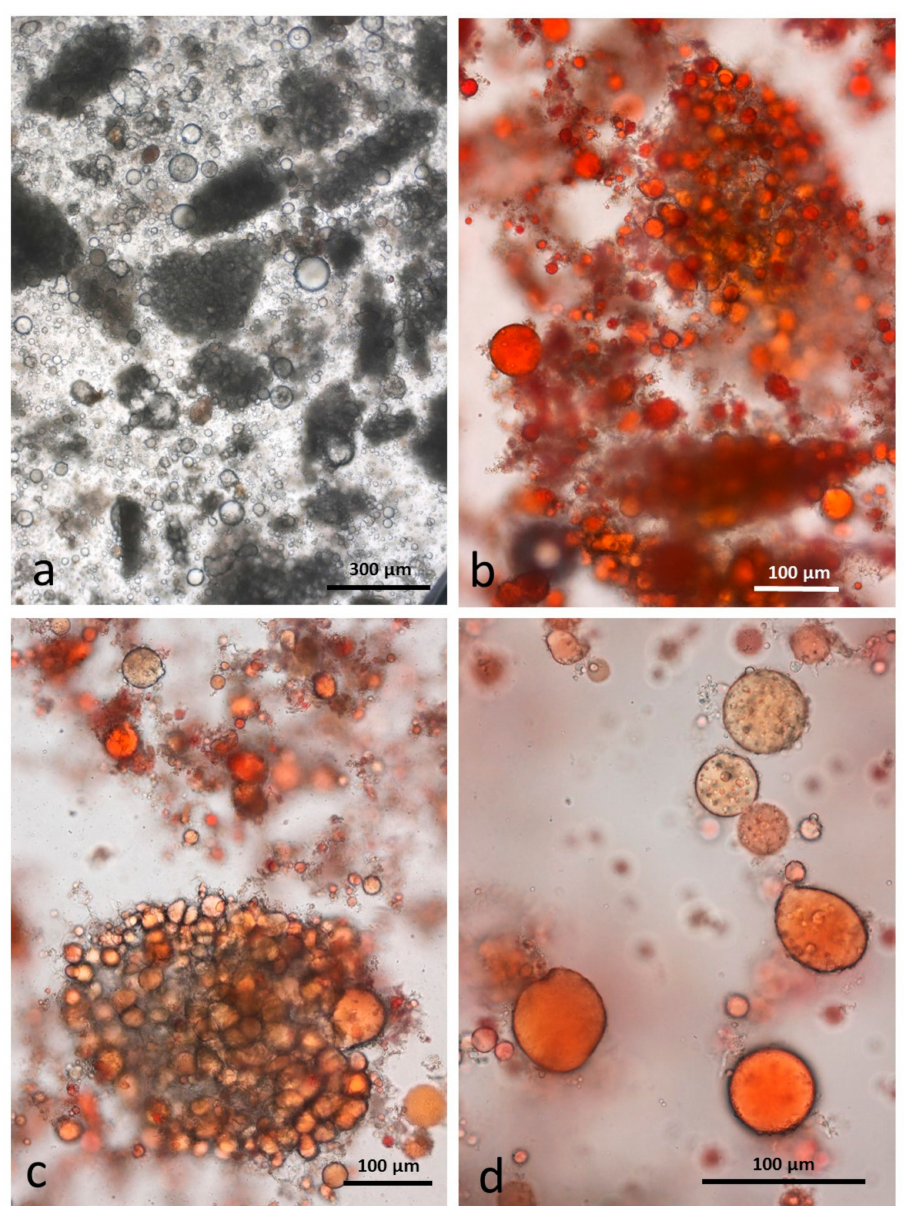
Figure 7. Chewed roasted chopped almonds stored in CDTA: ( a ) multicellular particles of almond tissue surrounded by released lipid drops; ( b ) particles surrounded by released lipid drops; ( c ) undamaged cells are full of coalesced lipid; ( d ) many of the released lipid drops are in the form of a water-in-oil-in-water emulsion which persist during storage in